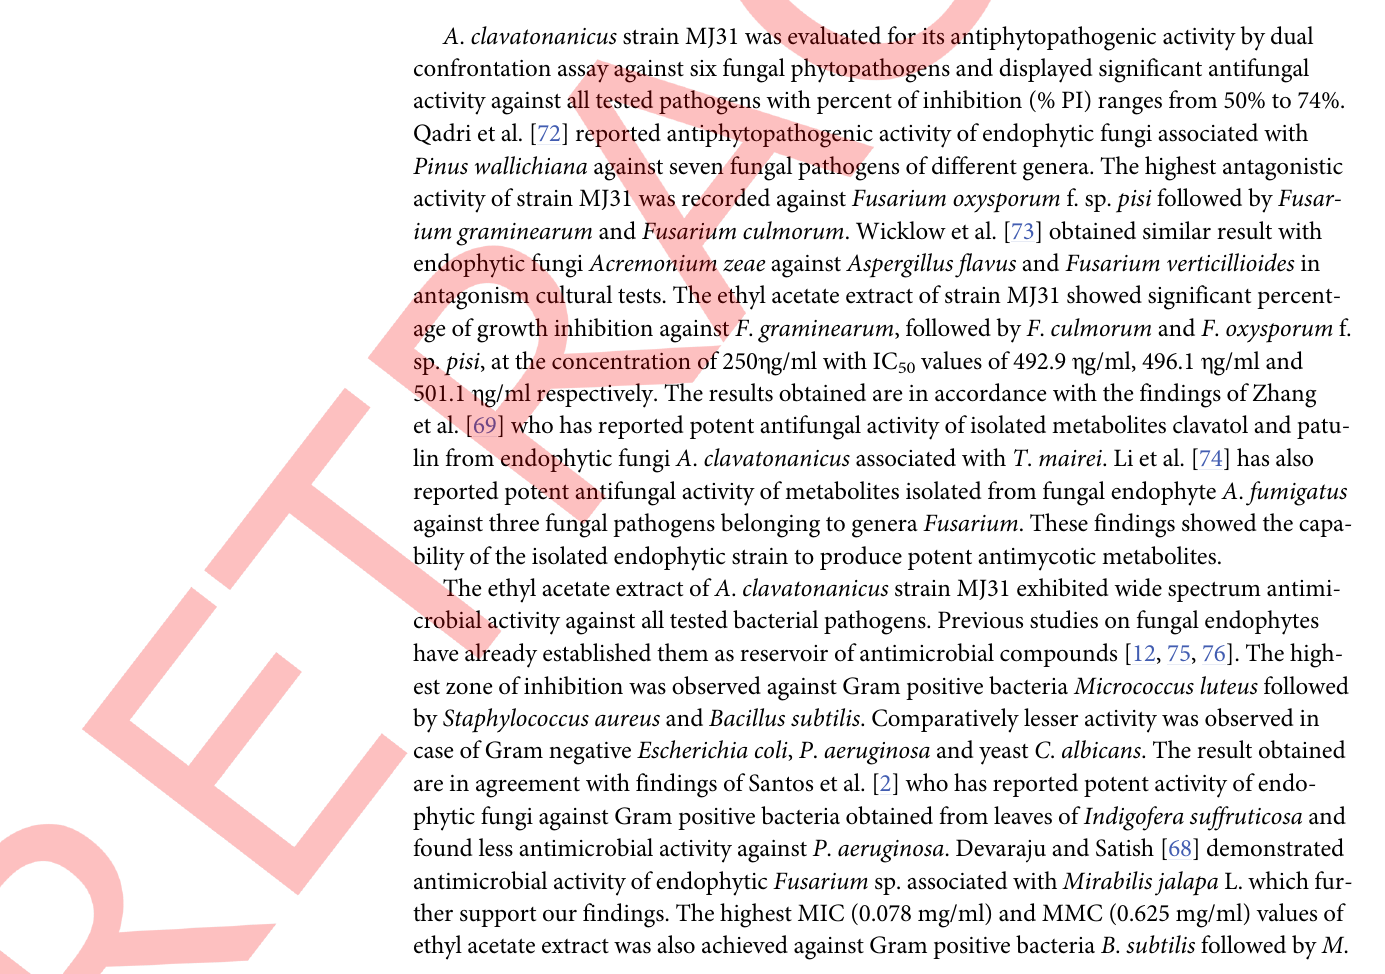
Fig 11. PCA Biplot based on the retention time (Each retention time corresponds to each detected volatile compound (VOC).